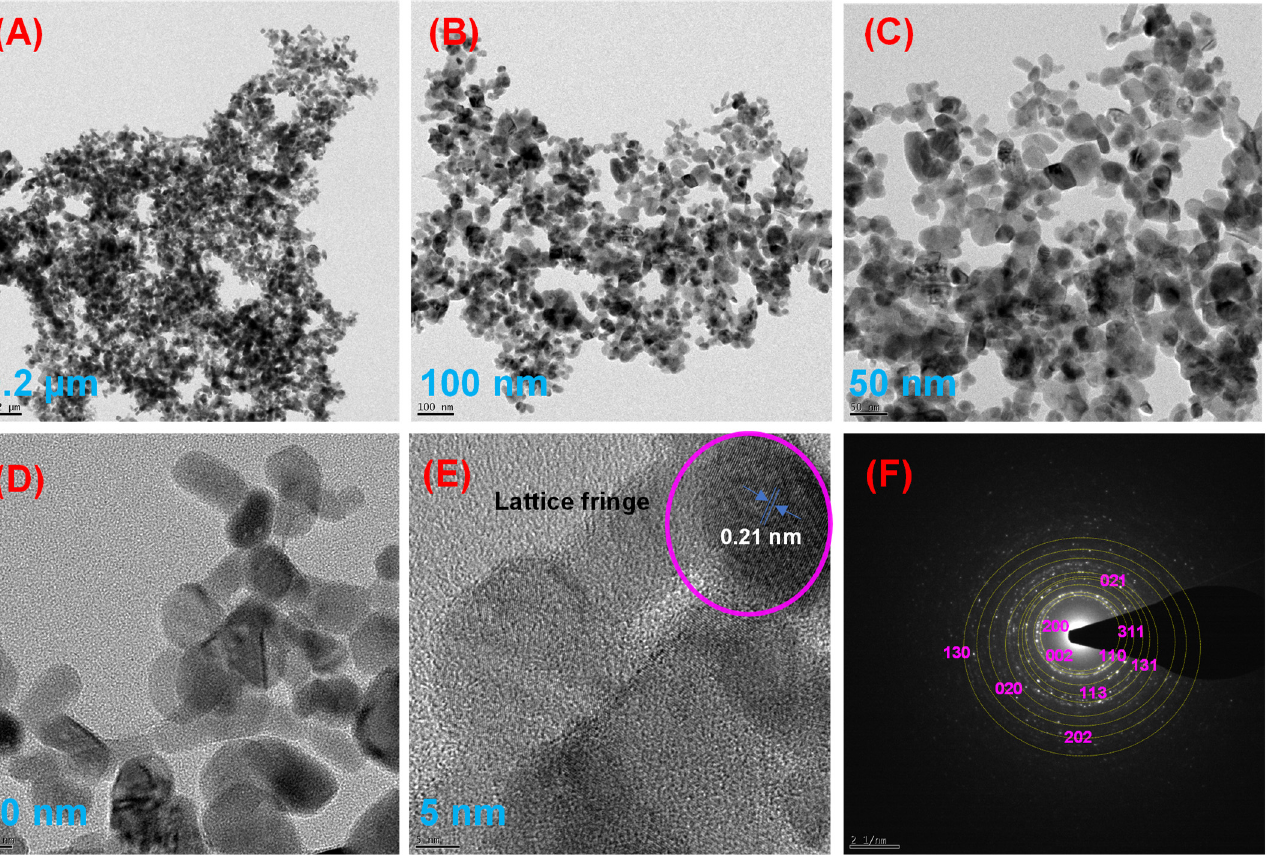
Figure 6. HR-TEM images of bio-reduced CuO NPs ( A – E ); SAED patterns of bio-reduced CuO NPs ( F ).